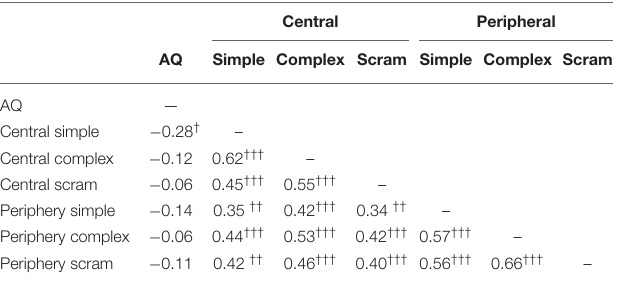
TABLE 2 | Kendall’s Tau correlations for AQ scores and perceptual switching rates.